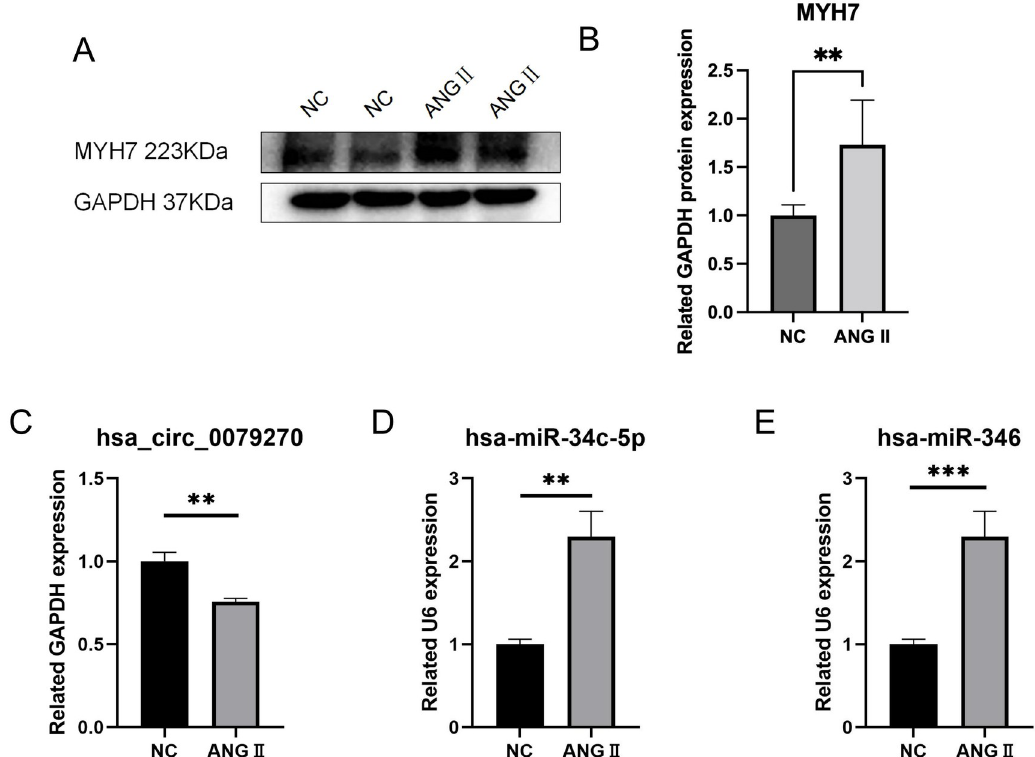
Fig 6. Experiment to verify potential targets. A and B, changes in the expression of MYH7 protein after ANG Ⅱ treatment. C, The RNA expression level of hsa_circ_0079270 in the cell hypertrophy model. D, the RNA expression of hsa-miR-34c-5p in the cell hypertrophy model. E, the RNA expression of hsa-miR-346 in the cell hypertrophy model. � < 0.05, �� < 0.01, ��� < 0.001, ���� <